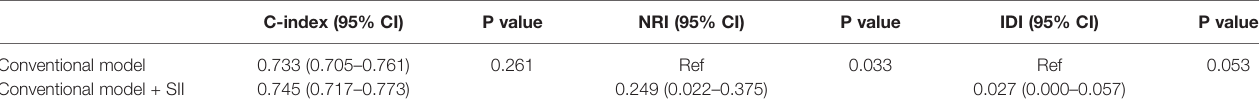
TABLE 5 | Evaluation of predictive models for overall survival.